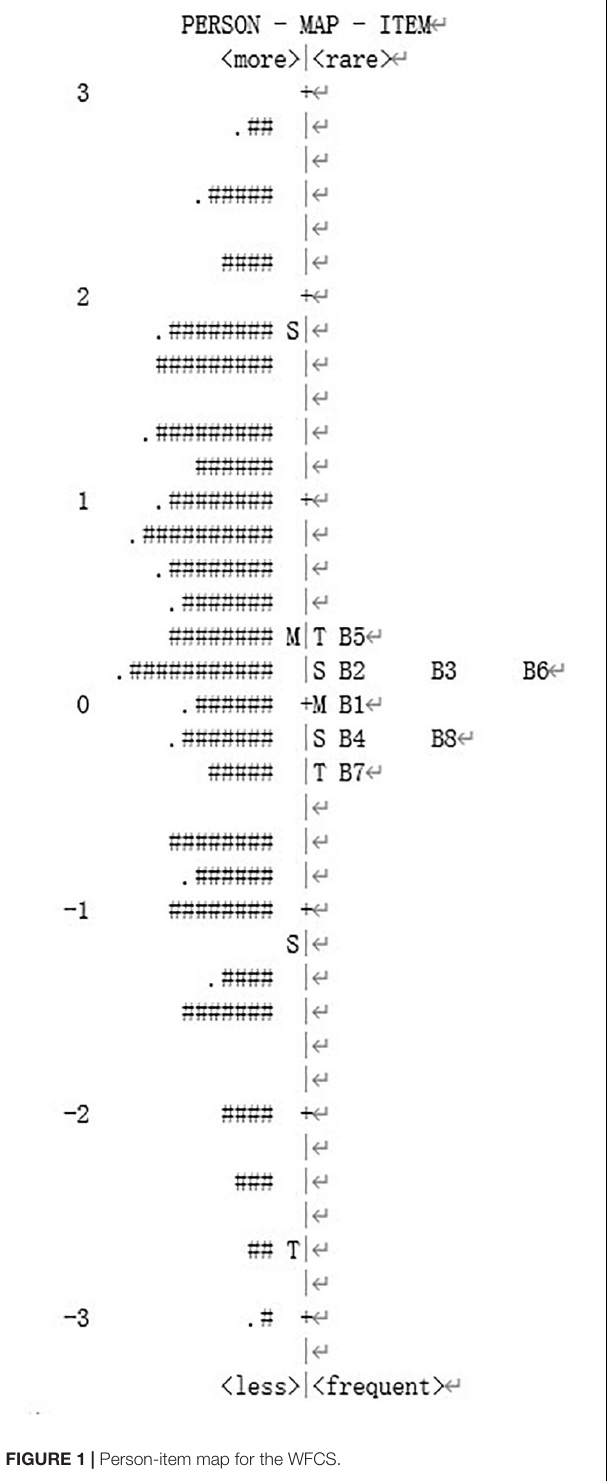
TABLE 2 | Model fit for each item.